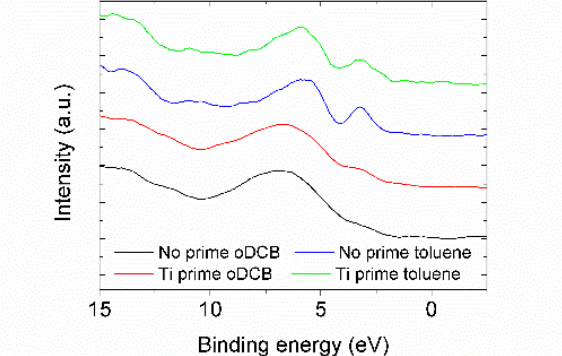
Figure 2. Density of states in the valence band region measured for the four different films.